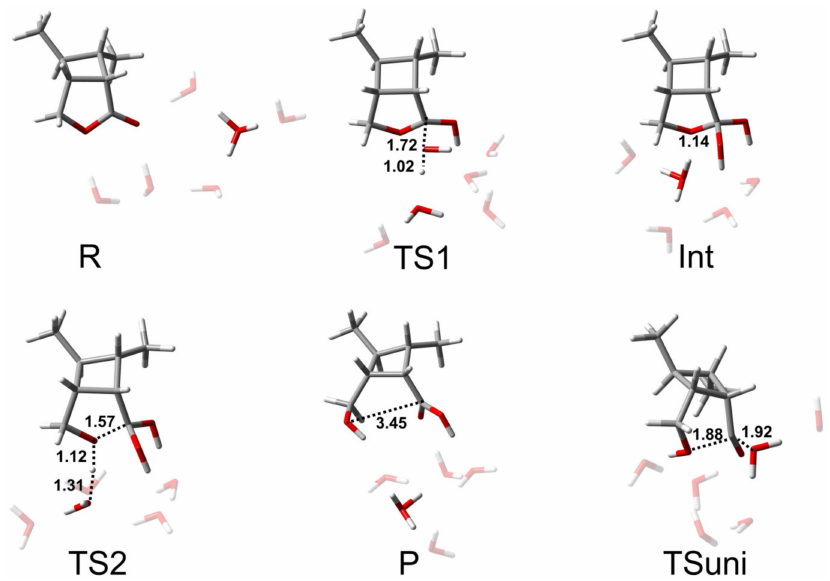
Figure 6. Structures of the stationary states of the A AC 2 reaction path of CBL + 5H 2 O + H 3 O + . The unit of distance is Å.